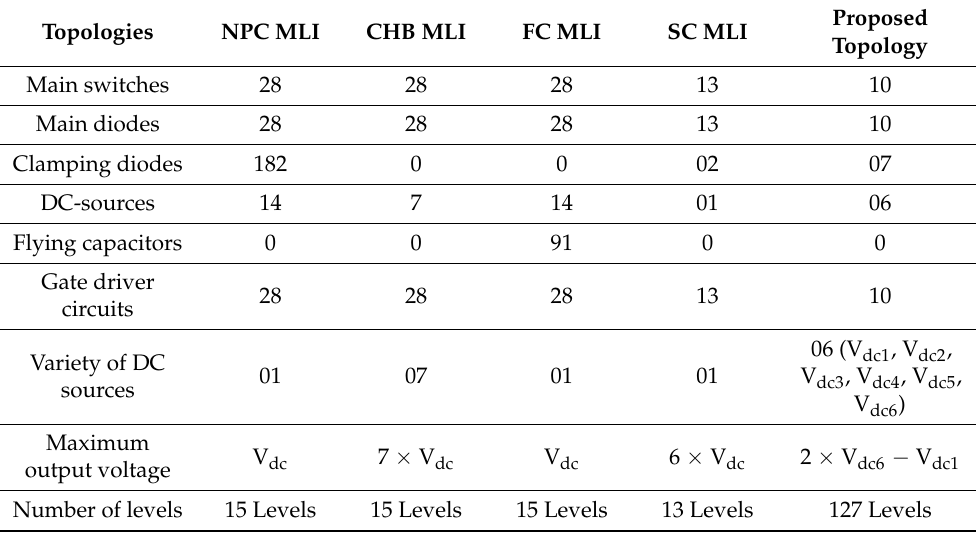
Table 3. Comparison of conventional and reduced switch